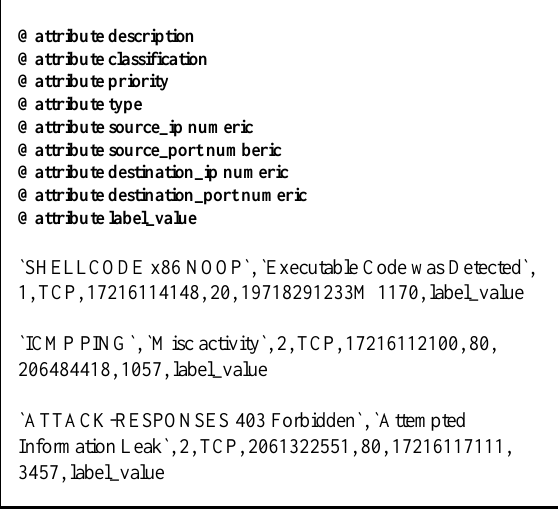
Fig. 4. Example contents of standard alarms in the compo- nent of data